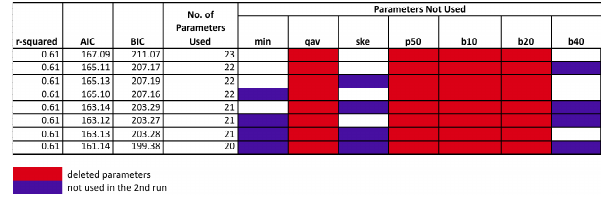
Figure 6: Second run of least squares using 23 parameters as input